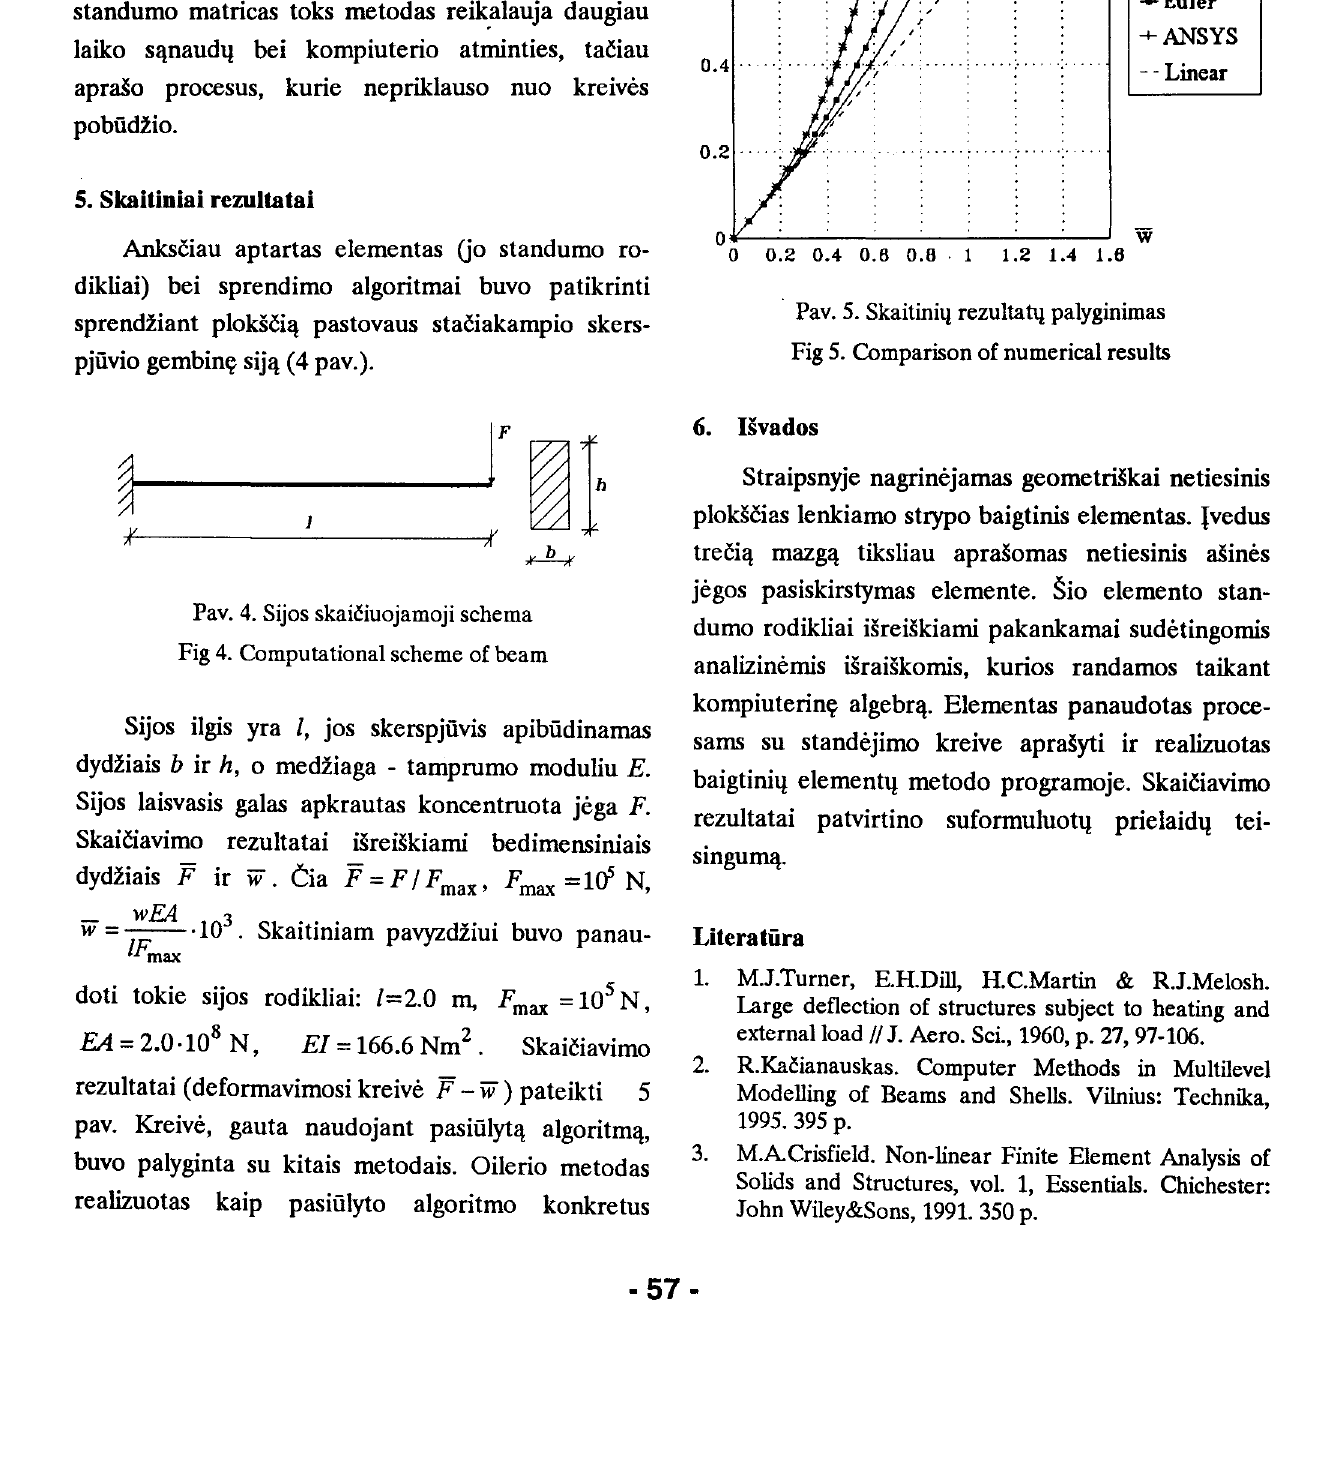
Fig 5. Comparison of numerical results 6. ISvados Straipsnyje nagrinejamas geometrukai